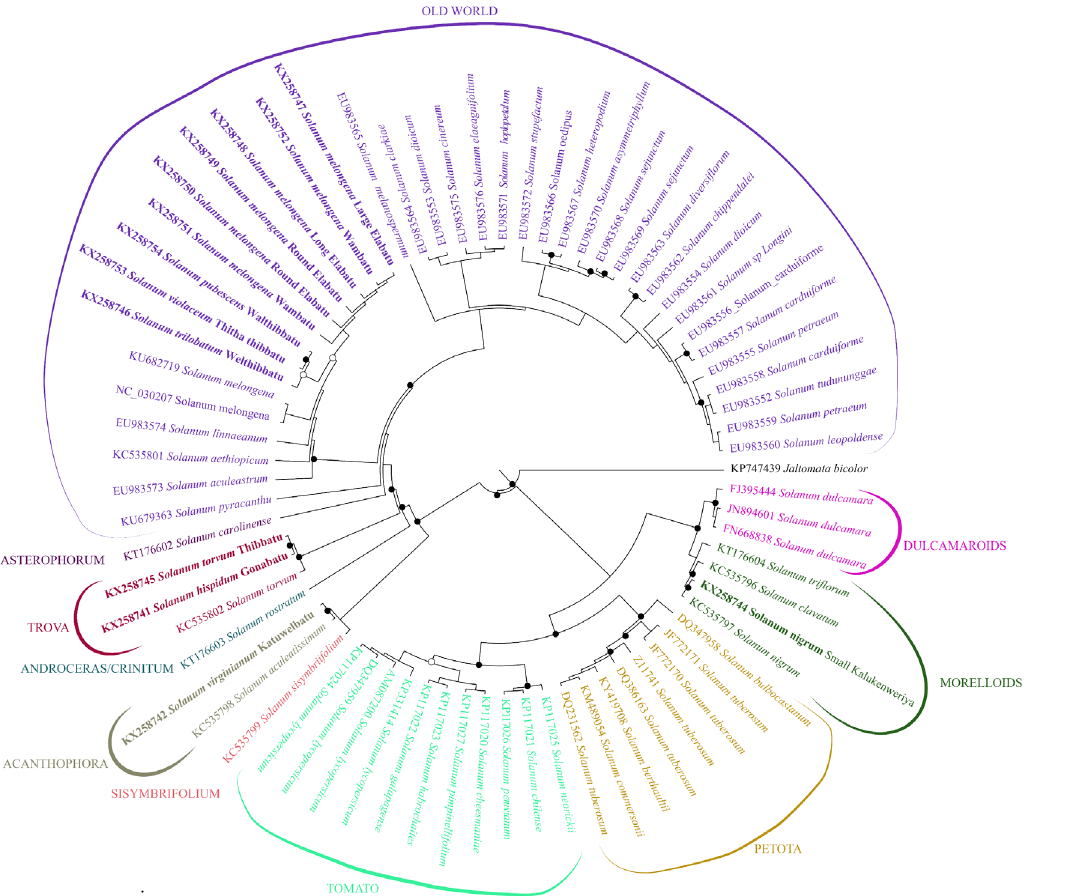
Figure1 : The majority rule consensus tree constructed on Maximum Likelihood (ML) framework. The major phylogenetic groups of Solanum spp. included in this analysis are presented. The node support values are given on its respective nodes indicated either in black dots (over 95 posterior probability and 100 bootstrap value) or white dots (over 85 posterior probability and 95 bootstrap value). The nodes containing posterior probabilities lower than 85 and bootstrap values less than 90 are not shown as dots. The Operational Taxonomic Units of Sri Lankan Solanum spp. are indicated in bold